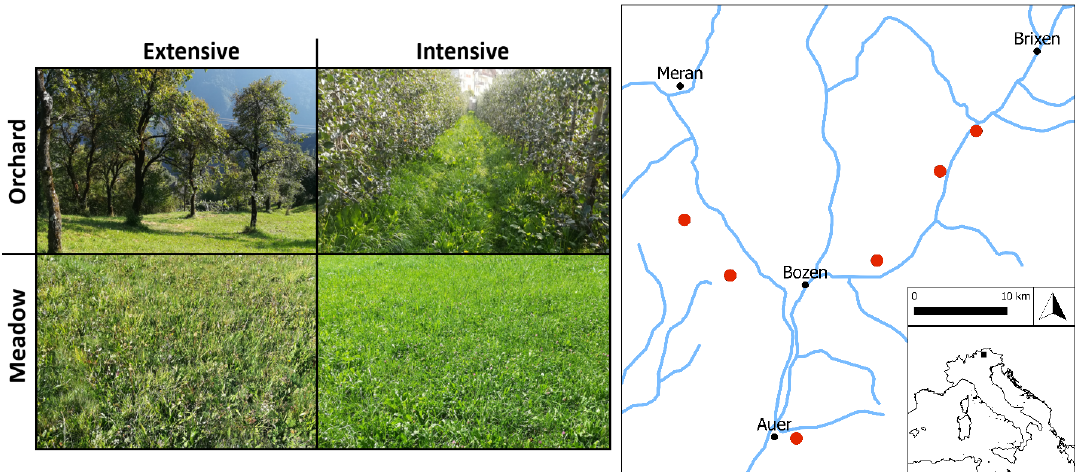
Figure 1. Schematic representation of the four differently managed field types located in each of the six sampling locations depicted in the map (red dots). The map shows a central excerpt from South Tyrol, the northernmost Province of Italy.